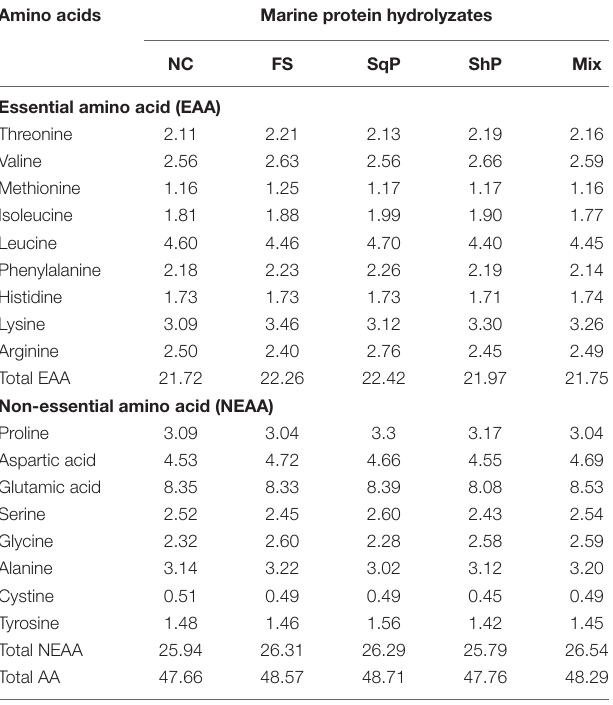
TABLE 1 | Ingredient composition and proximate analysis of the experimental diet (% dry matter).